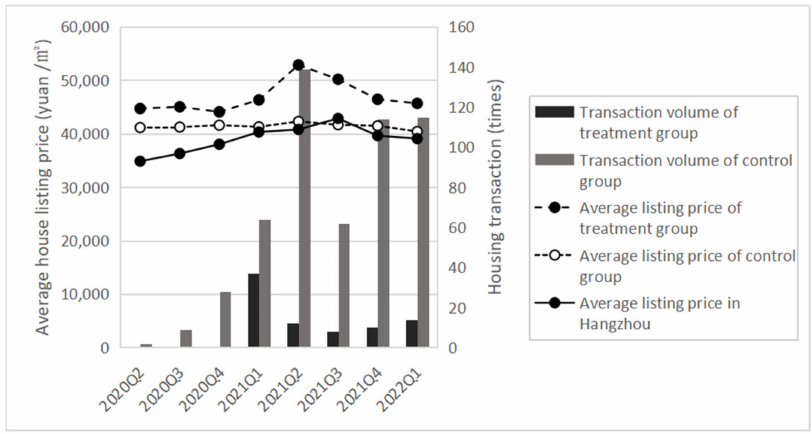
Figure 1. Real Estate Market in the Study Area from 2020Q2 to